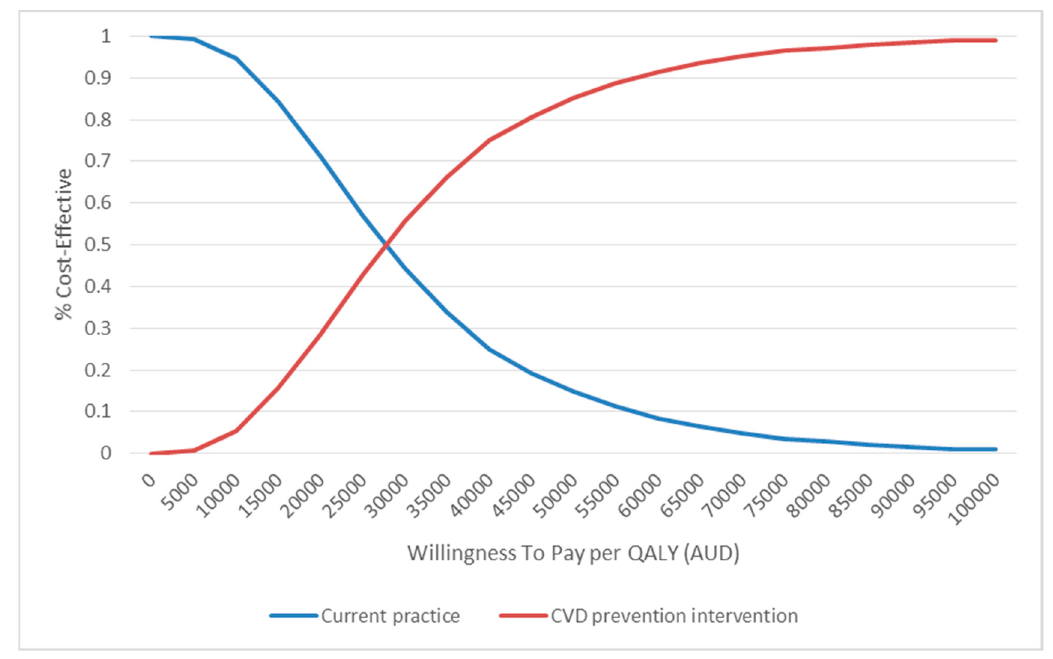
Figure 2. Cost effectiveness acceptability curve. QALY: quality-adjusted life year; Note: the y-axis represents the probability of the intervention being cost-effective as determined by the incremental cost-effectiveness ratio; the x-axis represents the change in WTP/QALY threshold.